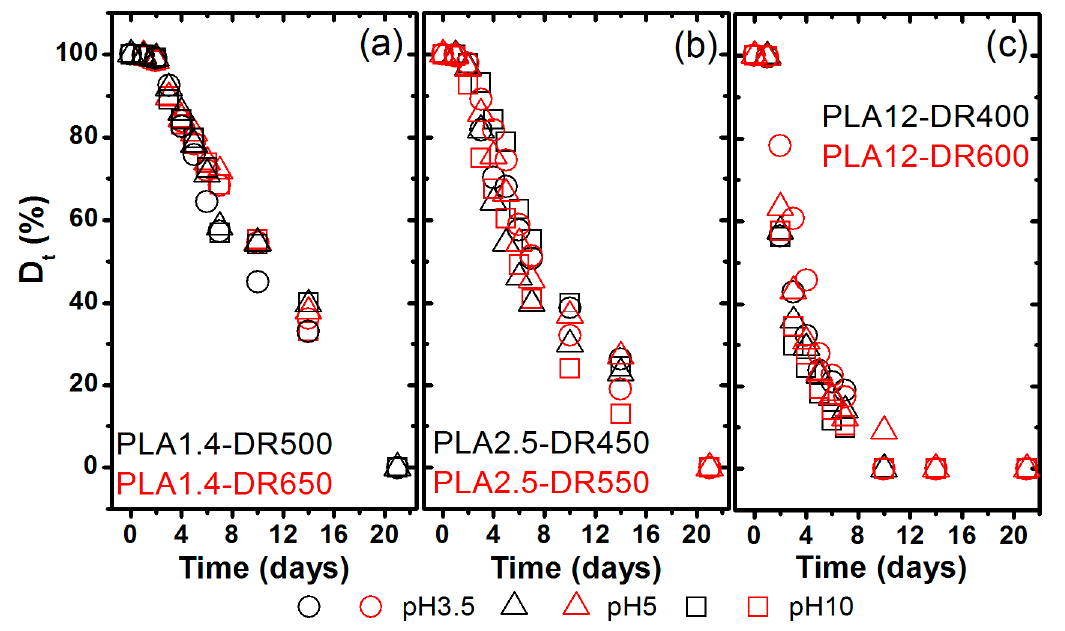
Figure 3. Changes of the mass percent remaining of the studied samples during thermal-supported hydrolytic degradation: ( a ) fibres made from PLA Ingeo 6201D, ( b ) fibres made from PLA Ingeo 2002D, and ( c ) fibres made from PLA Ingeo 4060D.